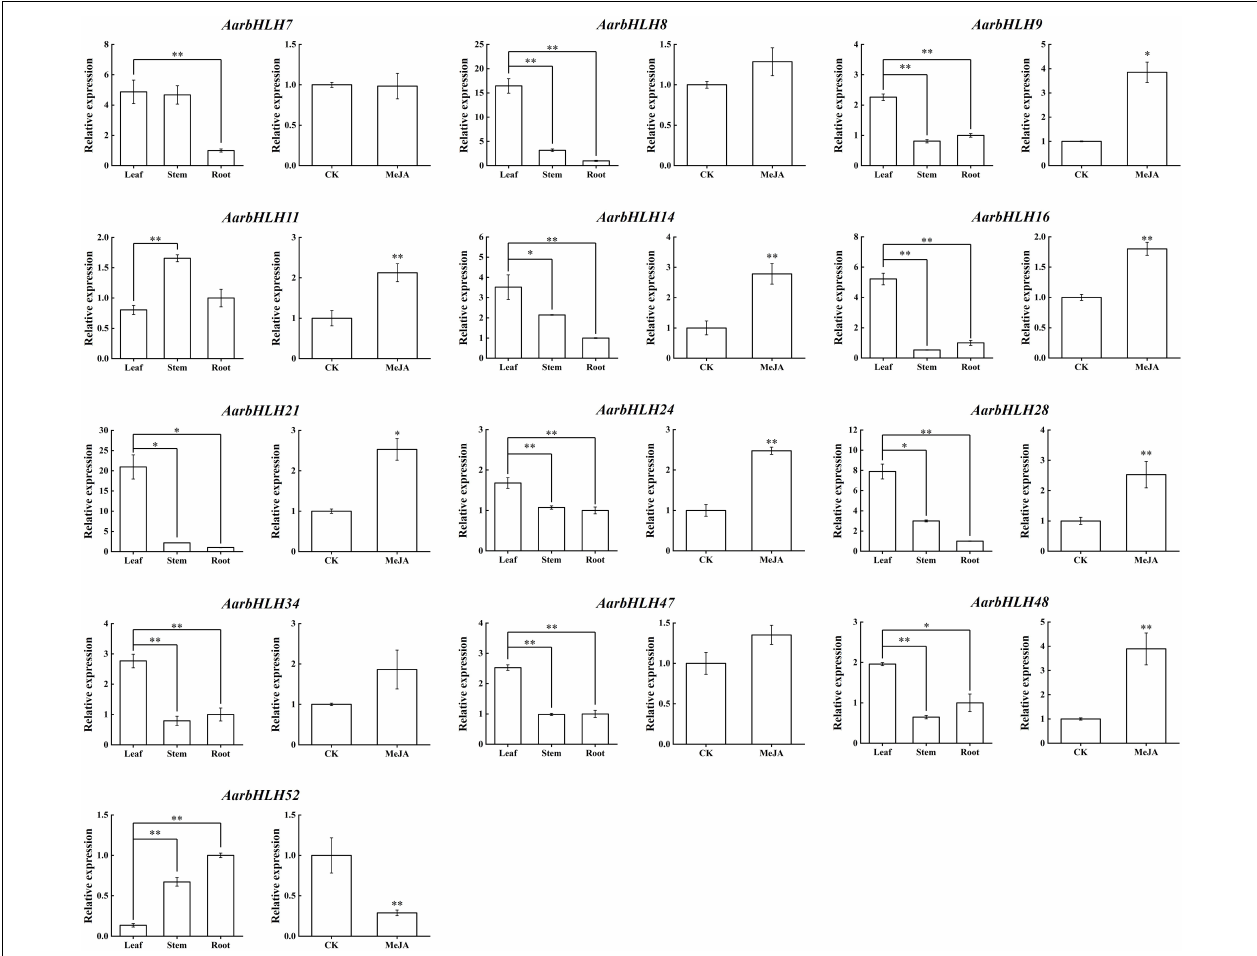
FIGURE 8 | qRT-PCR of candidate AarbHLHs for terpenoid synthesis in the LSR group and the MeJA group. The values represent means ± SD ( n = 3). ∗ Means p -value < 0.05, and ∗∗ means p -value <